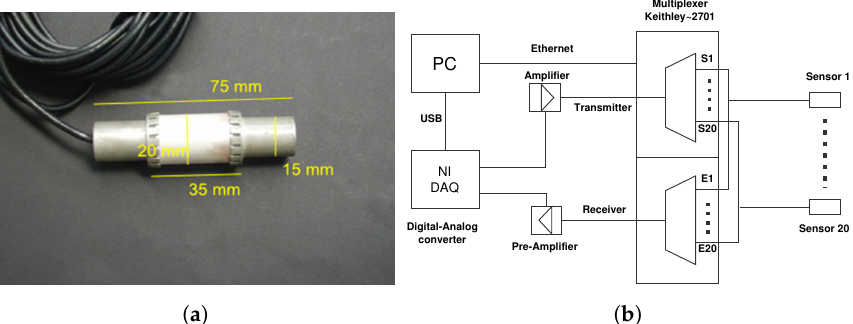
Figure 6. ( a ) dimensions of “SO807” [34]; ( b ) diagram of the data acquisition system.